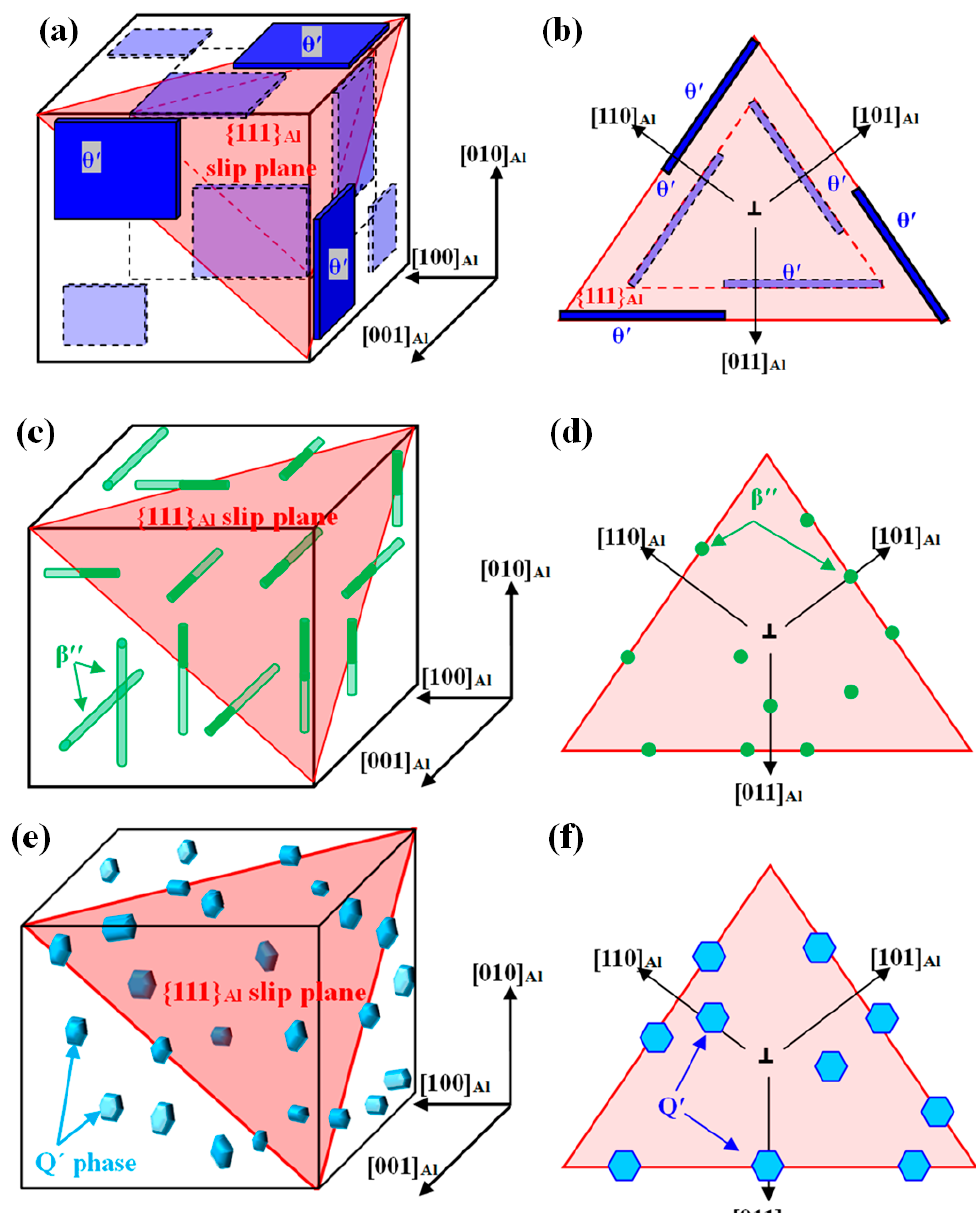
Figure 23. Schematic diagrams showing ( a ) distribution of lamellar β ’’ precipitates in the Al matrix and ( b ) projection of the intersected β ’’ precipitates in a {111} Al plane ( c ) distribution of lamellar Q’ precipitates in the Al matrix and ( d ) projection of the intersected Q’ precipitates in a {111} Al plane ( e ) distribution of lamellar θ ’ precipitates in the Al matrix and ( f ) projection of the intersected θ ’ precipitates in a {111} Al plane.